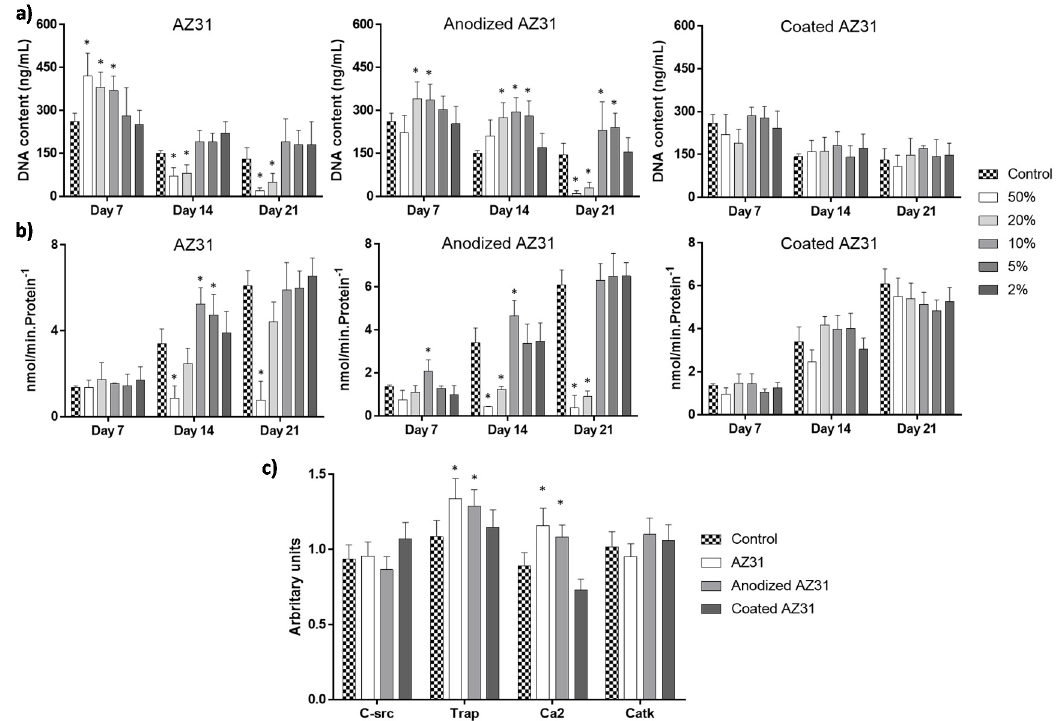
Figure 6. Human PBMCs cultures exposed to the extracts from the Mg − based substrates (AZ31, anodized AZ31 and coated AZ31), at days 7, 14, and 21. ( a ) DNA content; ( b ) TRAP activity; ( c ) expression of osteoclastic genes. * Significantly different from control cultures (absence of the extracts).